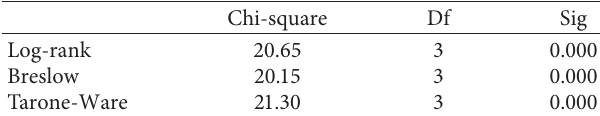
Table 7: Overall test of BDCI.